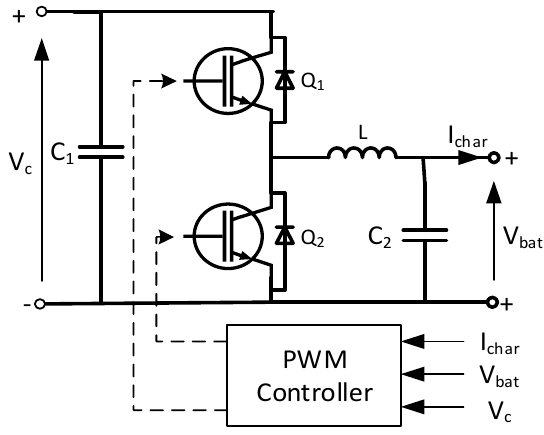
Figure 7. A buck–boost converter model.